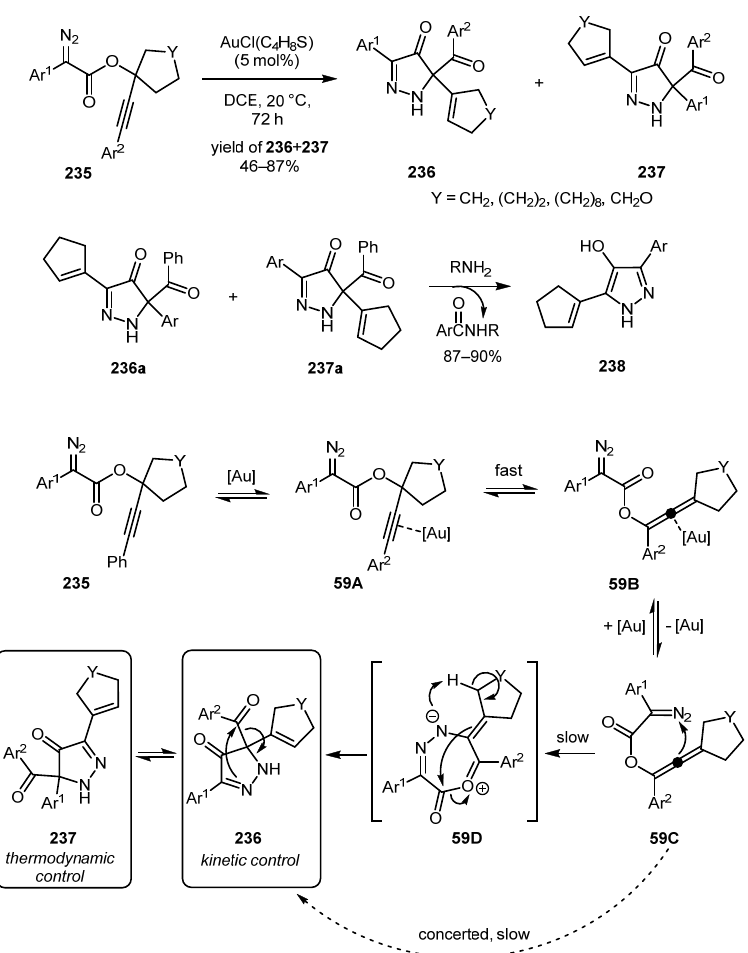
Molecules 2021 , 26 , x FOR PEER REVIEW 37 of 74